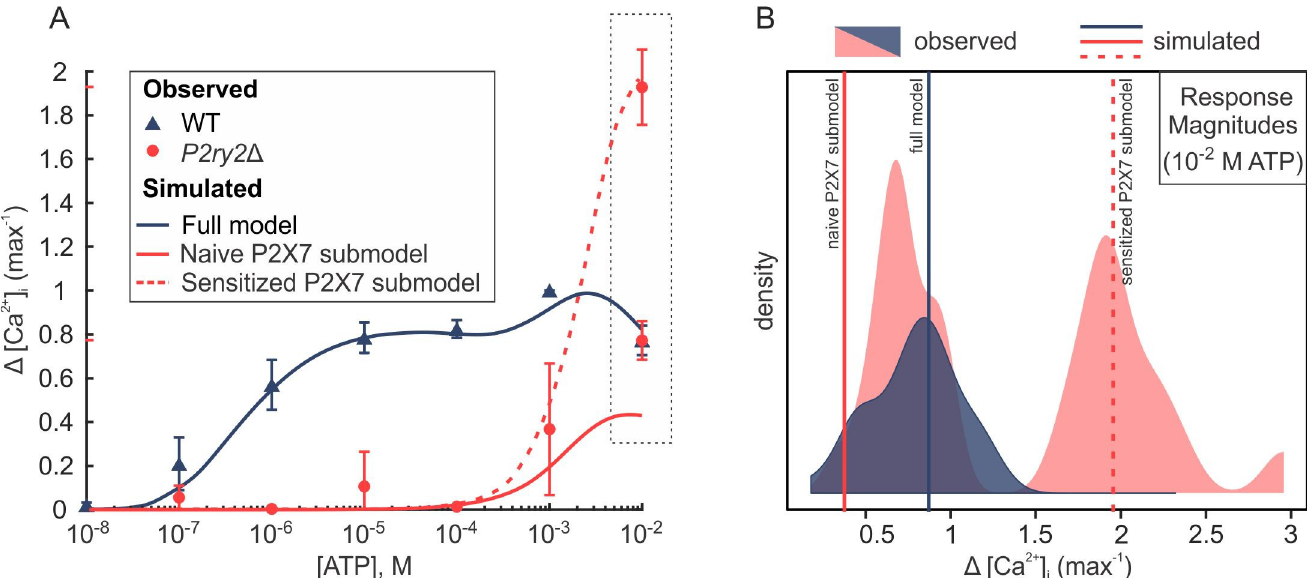
Fig 7. P2Y2 alters P2X7-mediated [Ca 2+ ] i response to high [ATP]. (A) The magnitude dose-responses of ATP-induced [Ca 2+ ] i elevations. Markers indicate experimental means ± SEM in wild-type (WT; blue ) and P2ry2 Δ ( red ) C2-OB cells. Curves indicate simulated data generated by the full model ( blue ), a P2X7 submodel initiated from the na ï ve closed state C 1 ( solid red curve ), or a P2X7 submodel initiated from the sensitized closed state C 4 ( dashed red curve ). (B) Density distributions of experimental Ca 2+ response magnitudes to 10 − 2 M [ATP] in WT cells ( blue density; unimodal) and P2ry2 Δ cells ( red density; bimodal). Vertical lines show simulated response magnitudes (10 − 2 M [ATP]) obtained by the full model ( solid blue line ), na ï ve P2X7 submodel ( solid red line ) and sensitized P2X7 submodel ( dashed red line ).